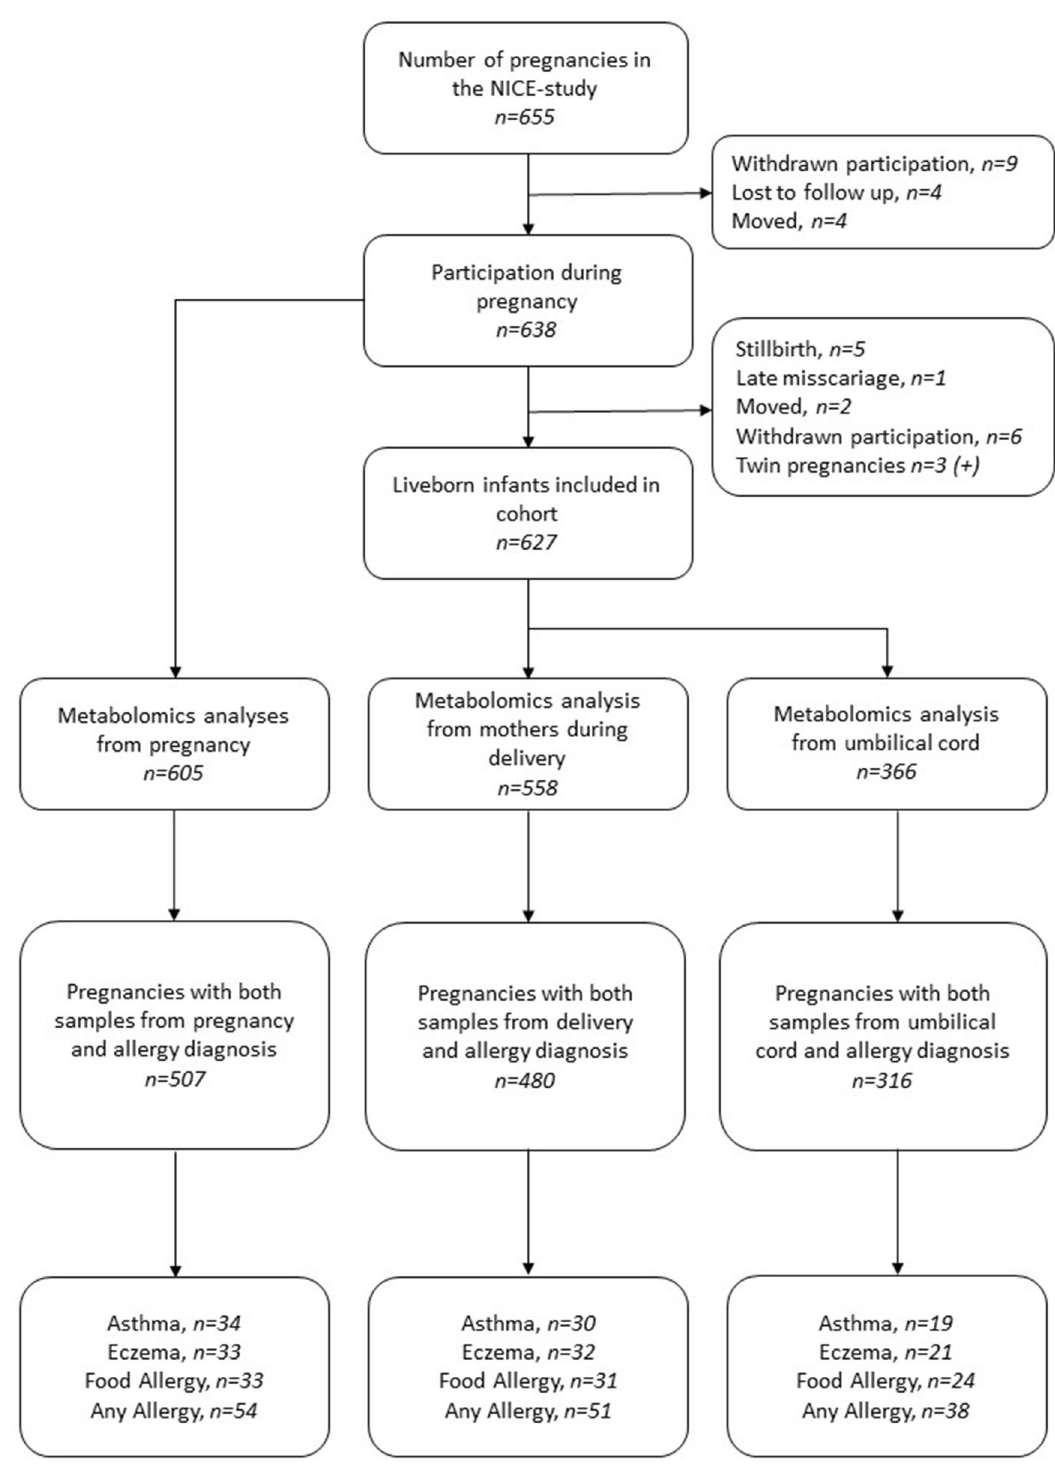
Figure 1. Overview of the number of cases and controls used in analyses. (+) indicating that three more children are added to the study due to twins being